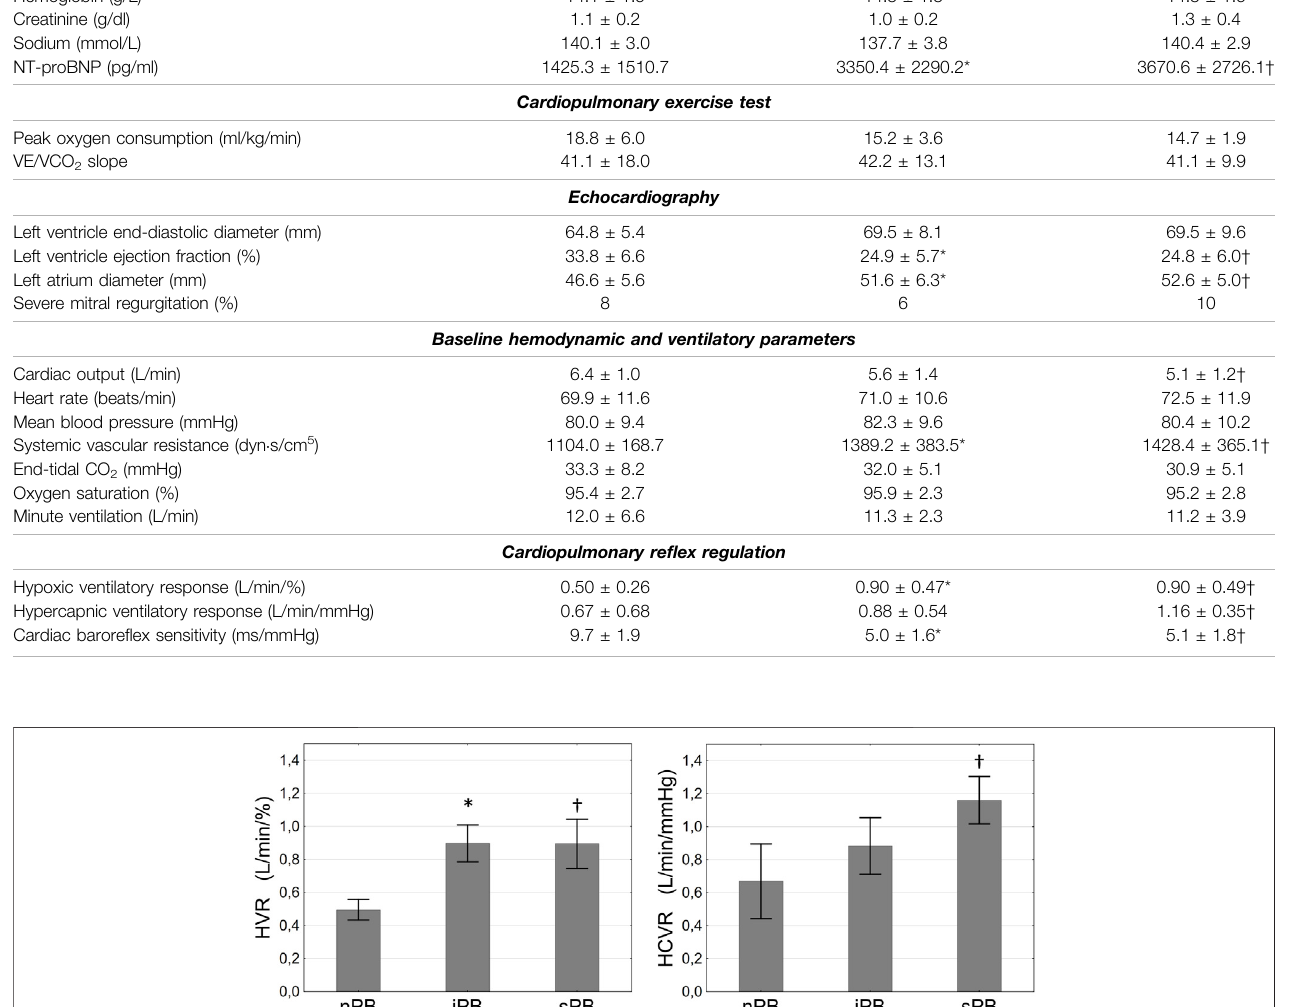
Frontiers in Physiology |